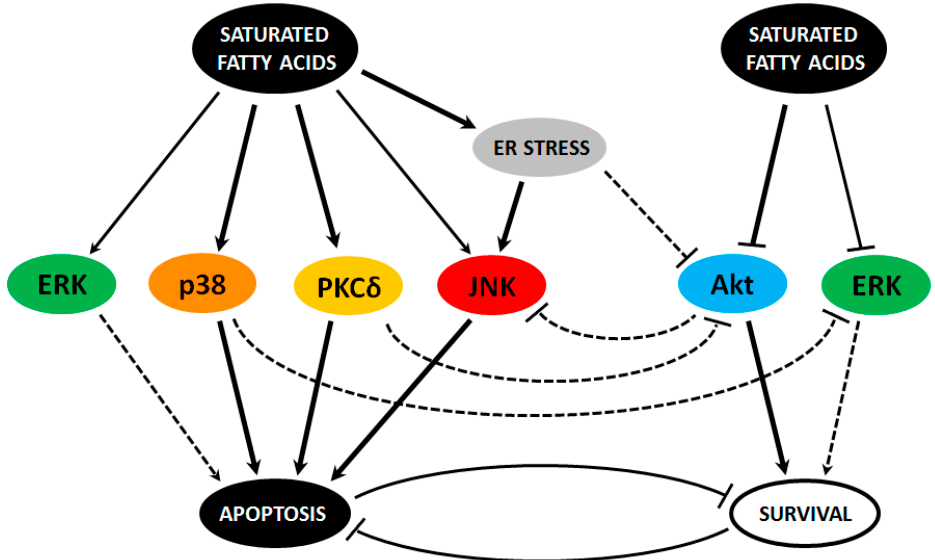
Figure 1. The involvement of c-Jun N-terminal kinase (JNK), protein kinase C (PKC), p38 mitogen-activated protein kinase (p38 MAPK), extracellular signal-regulated kinase (ERK), and Akt kinases and their pathways in apoptosis induction by saturated fatty acids (FAs) in pancreatic β -cells. Solid lines represent relationships with a reasonable probability where bold solid line means more important relationship. Dashed lines represent possible, but less certain,